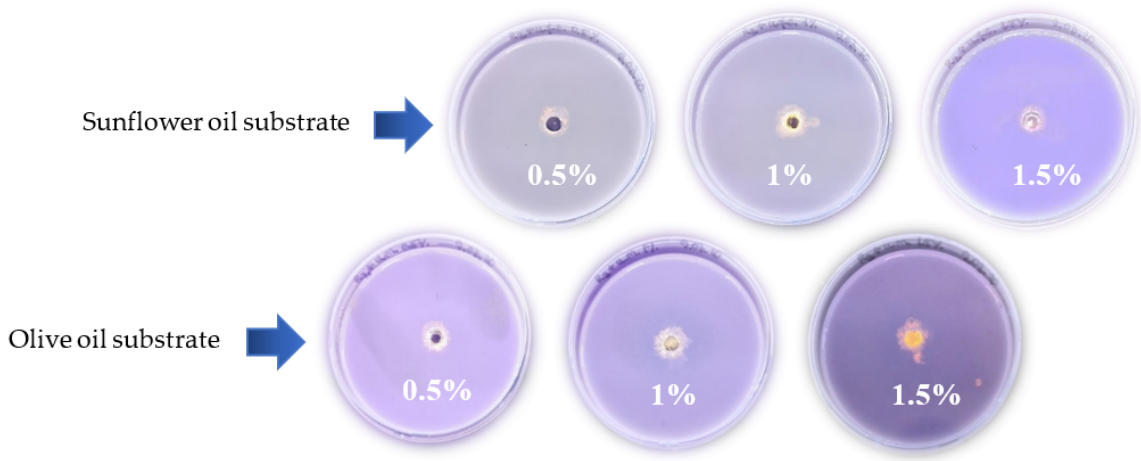
Figure 2 . Lipolytic activity on vegetable oil substrates by formation of fluorescent complex.